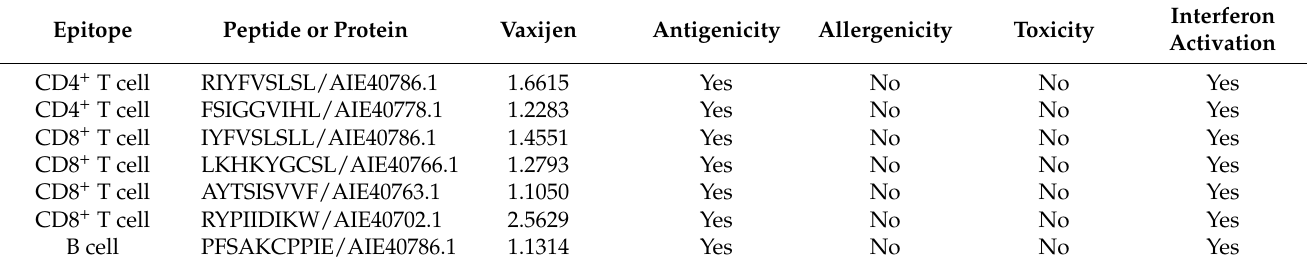
Table 2. The epitopes identified for vaccine engineering along with the analysis of their toxic, allergic, antigenic, and interferon- γ activation